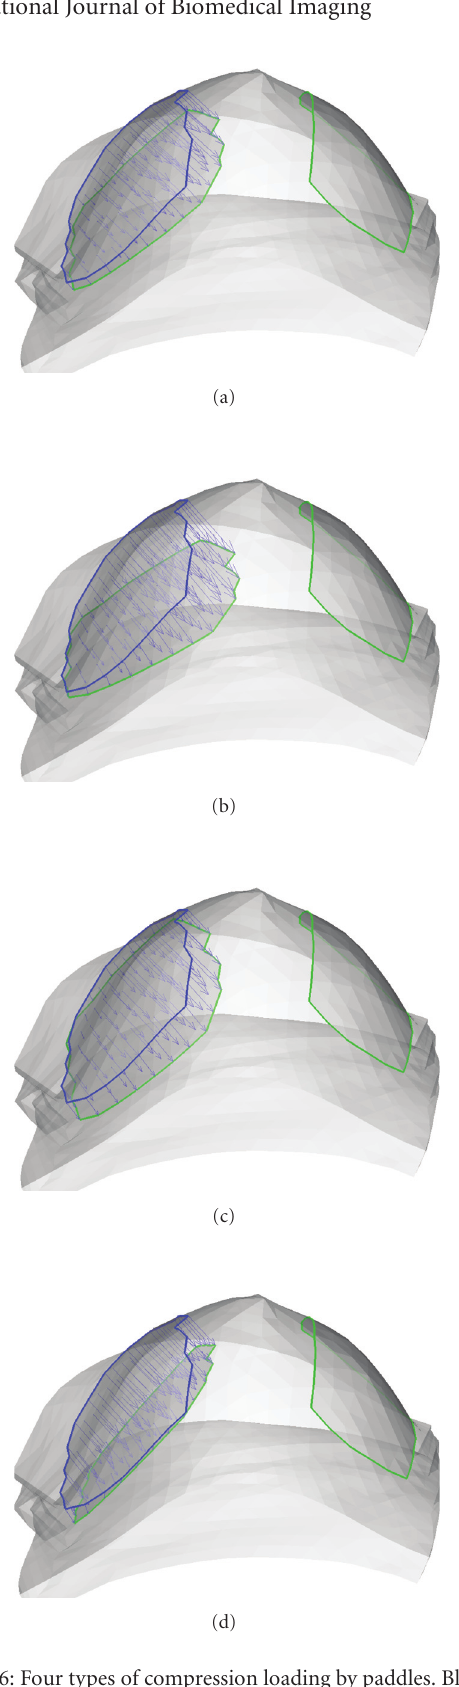
Figure 6: Four types of compression loading by paddles. Blue lines represent paddle locations before loadings, green lines represent after loadings. Note that the right paddle is fixed for all loadings.